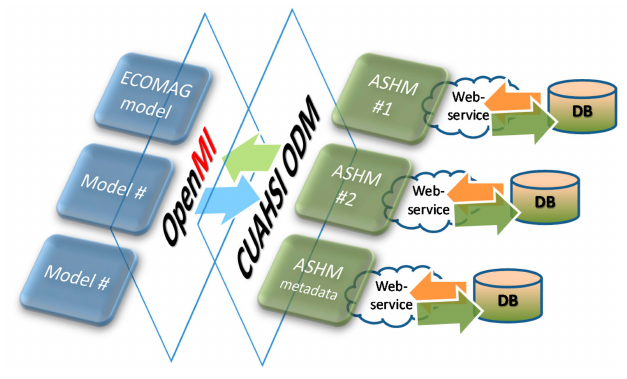
Figure 3. Scheme of two-level ECOMAG-AHMS